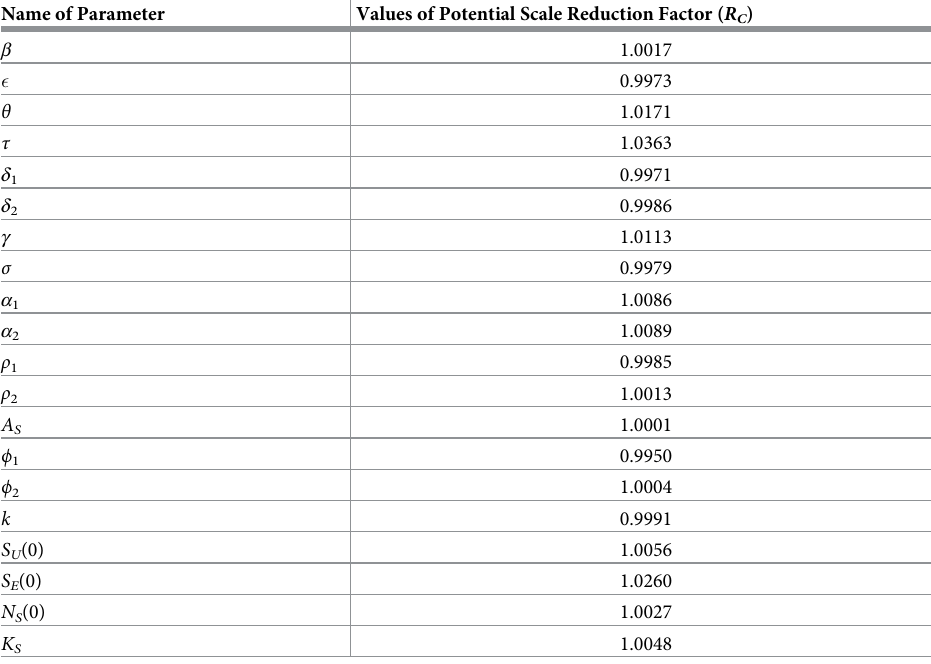
Table 3. The report of Gelman-Rubin diagnostics Test for